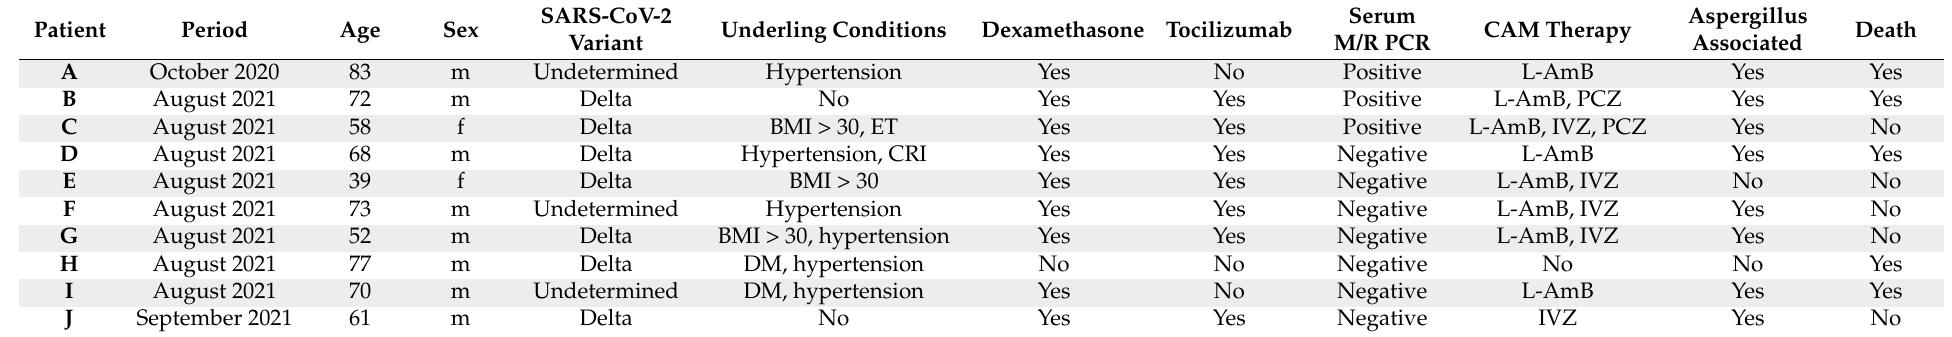
Table 1. Characteristics of COVID-19 Patients with Mucorales-positive PCR in respiratory